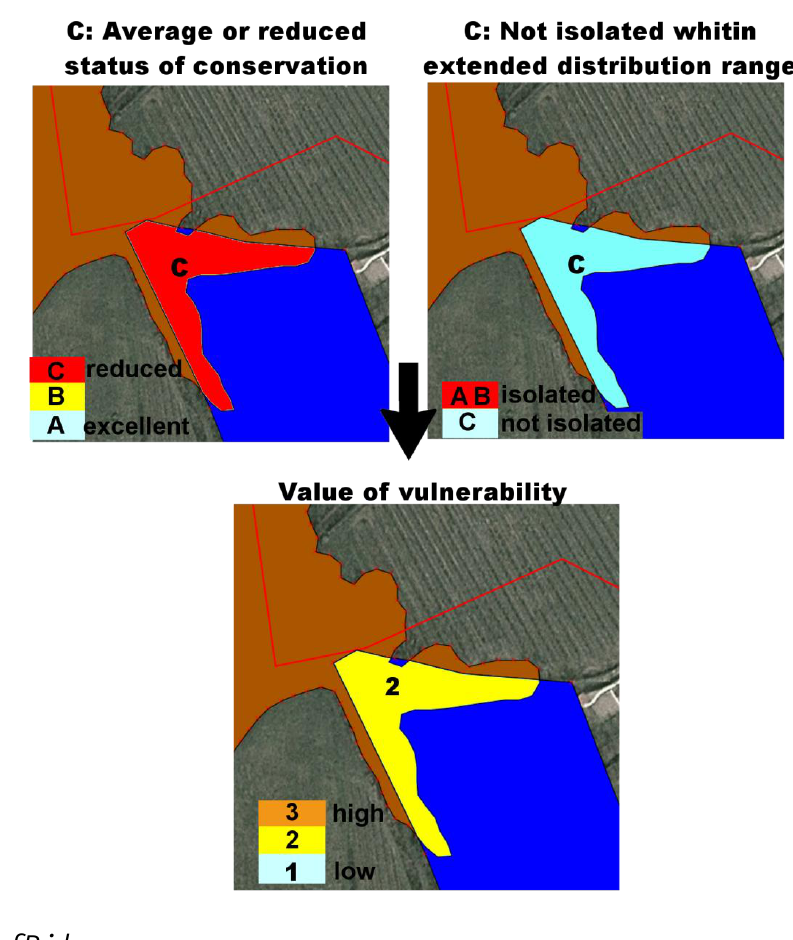
Figure 15. Vulnerability value from a combination of information from conservation and isolation.